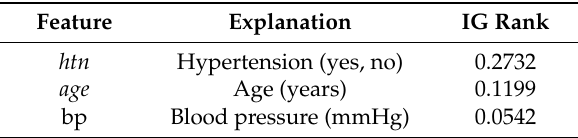
Table 3. The feature of dataset III and its Information Gain (IG)